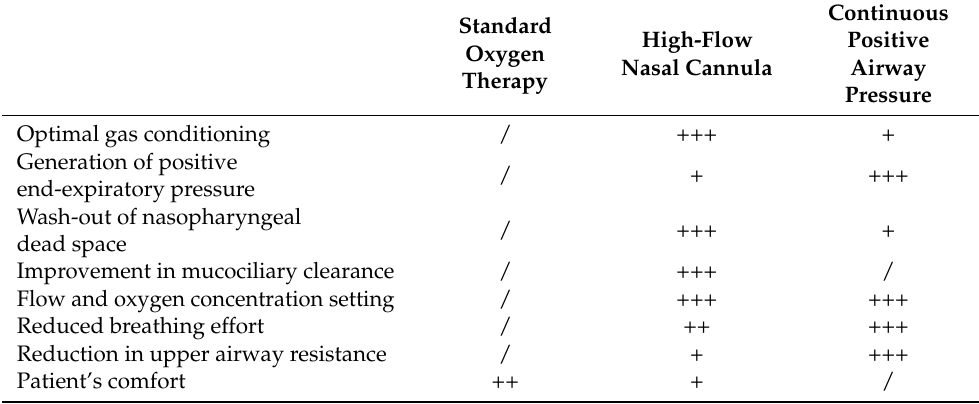
Table 4. Comparison of the characteristics among standard oxygen therapy, high-flow nasal cannula, and continuous positive airway